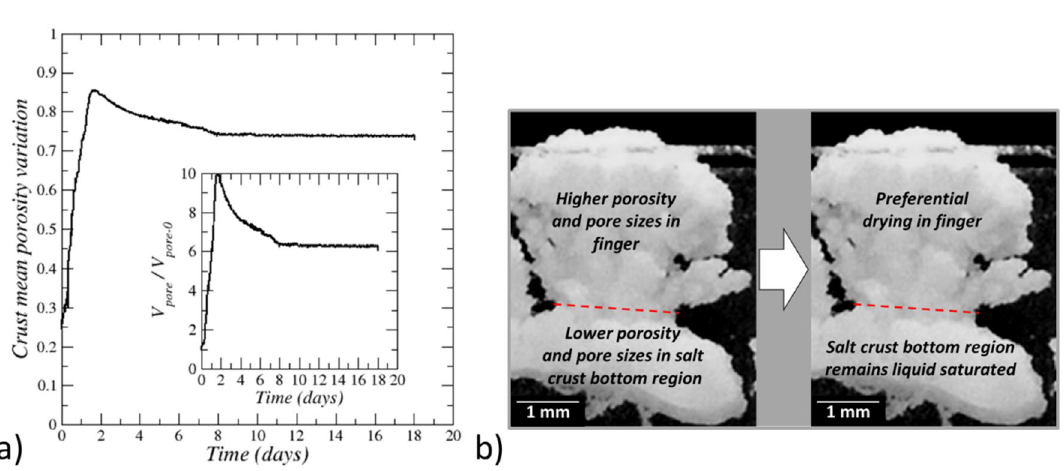
Figure 6. Crust porosity variation. ( a ) Salt crust average porosity variation (assuming ε = 0.25 at t = 0). The inset shows the ratio between the corresponding salt crust pore volume and the salt crust pore volume at t = 0. ( b )